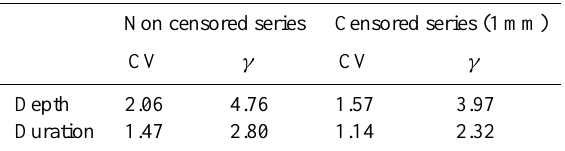
Table 2. Sample coefficients of variation (CV) and skewness ( γ ) of event rainfall depth and duration estimated for the Valencia